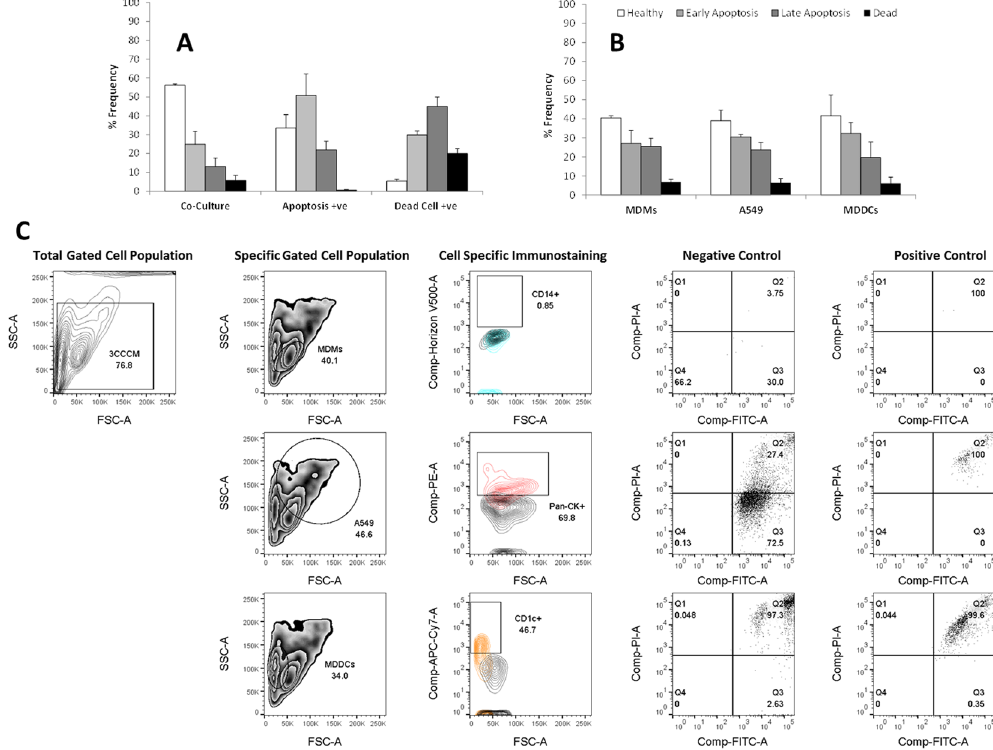
Figure 5. Investigation of the ability for the herein presented method to obtain a cell suspension of the 3D in vitro triple cell co-culture model to incite cell death, as determined with the Annexin V assay. Following detachment from a micro-porous membrane insert via EDTA-Trypsin treatment the level of cell death ( i.e. either apoptosis or cell death ( e.g. necrosis)) was determined for ( A ) the total cell suspension via two-colour flow cytometry (FACS), or ( B ) for each specific cell type of the co-culture system via five-colour FACS. In both ( A and B ), data shows the viability of the co-culture following 24 hours exposure at 37 °C, 5% CO 2 to either complete medium (negative control), Camptothecin at [0.002 mg/mL] (positive apoptosis control) or extreme freezing ( − 80 °C for 30 minutes) (positive dead cell ( i.e. necrosis) control). After implementing the specific gating strategy for the co-culture suspension (SI Fig. 1B) ( C ) indicates the gating strategy used to deduce the viability status of the cell cultures was defined as healthy, early apoptotic, late apoptotic or dead. All data was analysed using FlowJo (Version 10, TreeStar, USA). In ( A and B ) all data expressed is the mean ± standard error of the mean (SEM) of the %Frequency. Experimentation was repeated on three separate occasions in triplicate (n =